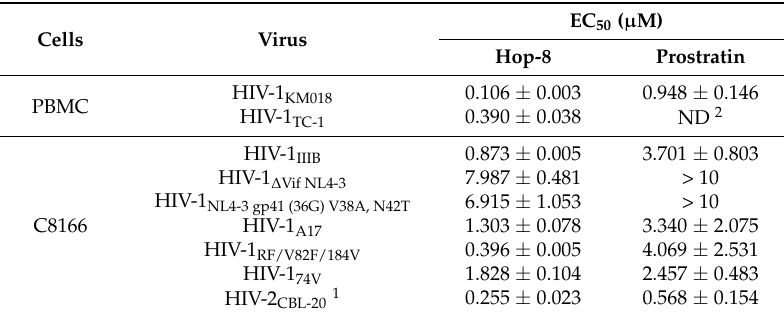
Table 1. The antiviral activity of